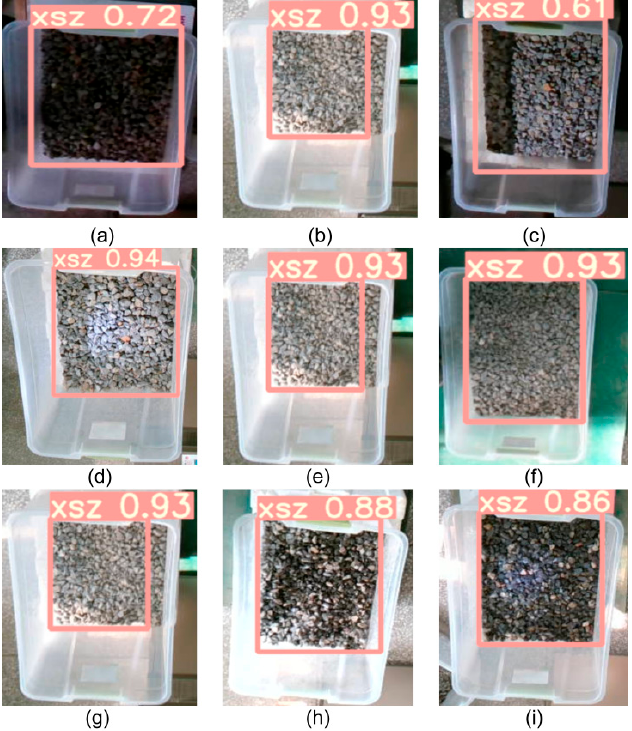
Figure 7. Small stones under different distances, light, and dry humidity. ( a ) is the small stones on a cloudy day, ( b ) is the small stones on a sunny day, ( c ) is the small stones of the night, ( d ) is the small stones at a distance of 1 meter, ( e ) is the small stones at a distance of 1.5 meters, ( f ) is the small stones at a distance of 2 meters, ( g ) is the small stones in the dry state, ( h ) is the small stones in the normal state, ( i ) is the small stones in the wet state.